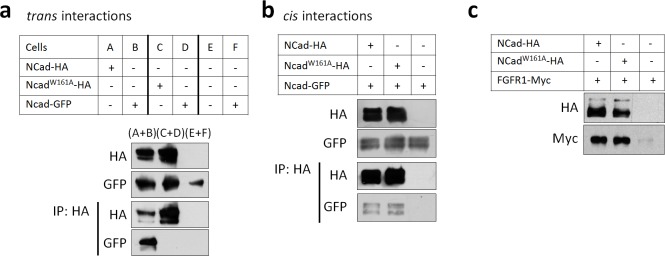
NCad W161A mutation inhibits trans but not cis homophilic binding.(a) Cells were transfected separately to express NCad-GFP (B, D and F), NCad-HA (A), NCadW161A-HA (C), or vector (E). Twice the amount of DNA was used for NCadW161A-HA transfection to equalize the protein level with NCad-HA. After transfection, cells were mixed as described in the table and re-plated allowing only trans interactions to be detected. 24 hr later, cells were lysed, immunoprecipitated with anti-HA antibody, and proteins detected by Western blot. (b) Cells were co-transfected with NCad-GFP and either NCad-HA, NCadW161A-HA or vector. Cells were then left in contact or kept in suspension to prevent cell contact and enable cis interactions only. Receptor interactions were then tested by co-immunoprecipitation as above. (c) NCadW161A increased the protein abundance of FGFR1 as efficiently as wild-type NCad. 293T cells were transfected for the expression of the indicated proteins. Twice the amount of DNA was used for NCadW161A in order to equalize protein levels. Cell lysates were analyzed by Western blot. All experiments were repeated three times with similar results.